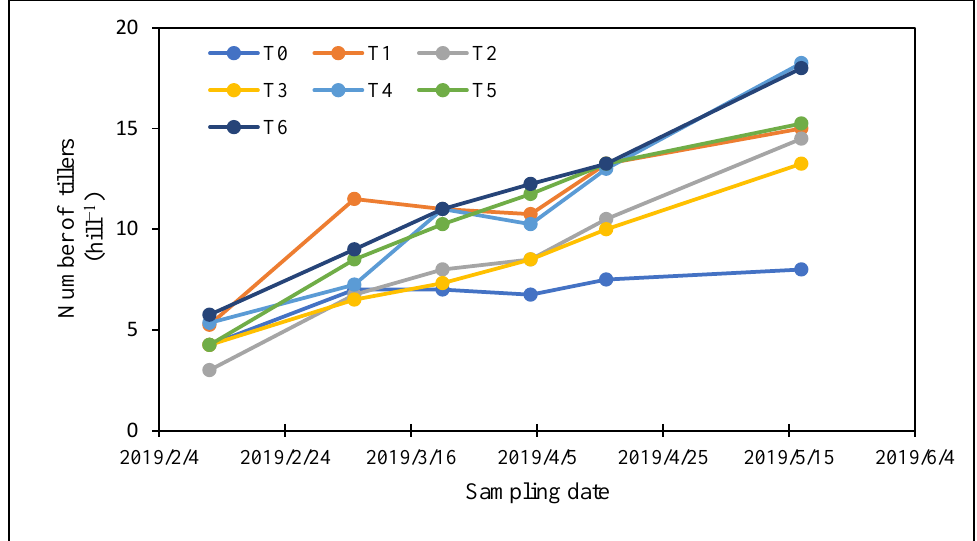
Figure 2. Effect of the different treatments on rice plant tillering; mean of 4 replicates; error bars were removed for clarity, T0: no fertilizer, T1: 100% urea, T2: 100% beef cattle manure, T3: 100% poultry litter, T4: 50% urea + 50% beef cattle manure, T5: 50% urea + 50% poultry litter and T6: 40% urea + 30% beef cattle manure + 30% poultry litter.